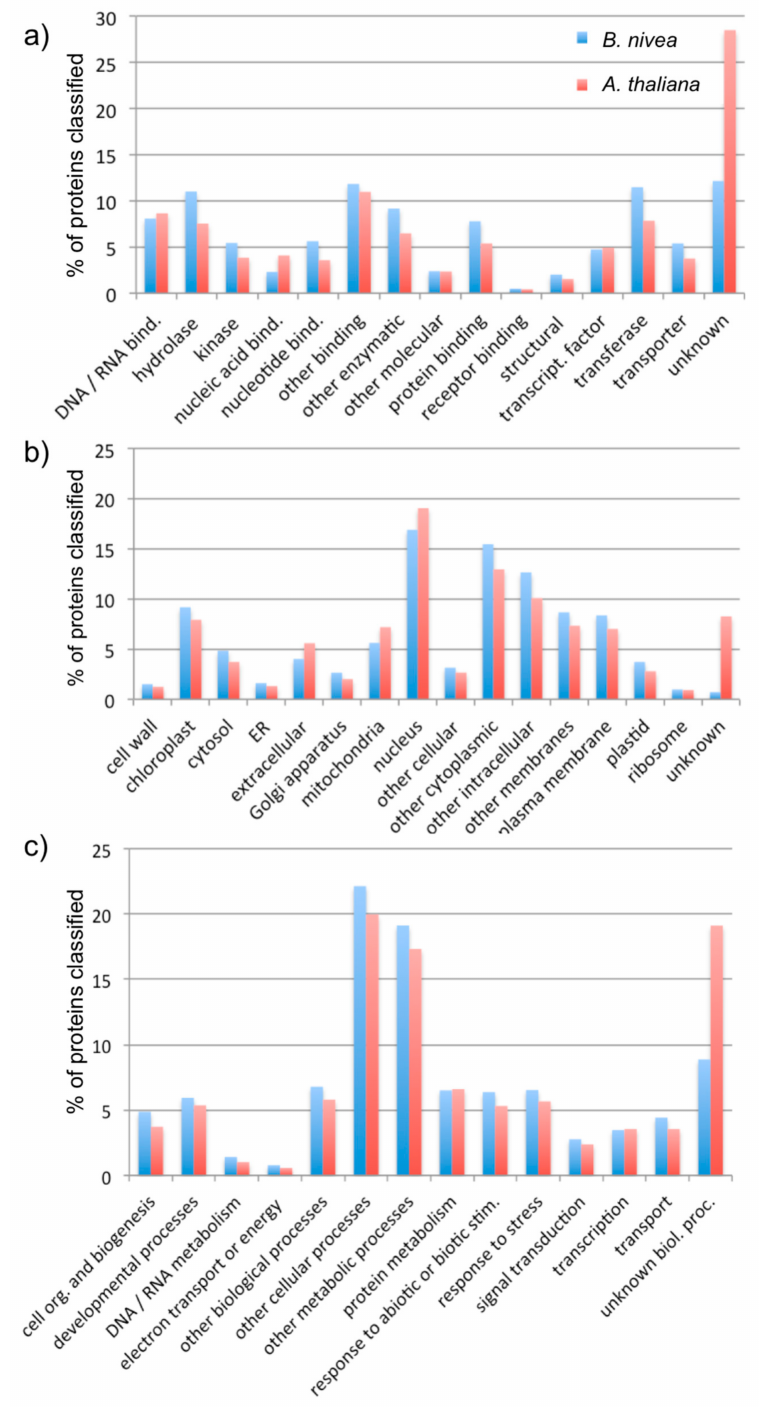
Figure 2. Gene Ontology (GO) categorization of predicted proteins among B. nivea scaffolds. The figure represents the proportion of proteins assigned to each category within the three aspects of ( a ) molecular function, ( b ) cellular compartment, and ( c ) biological process for both B. nivea and A. thaliana